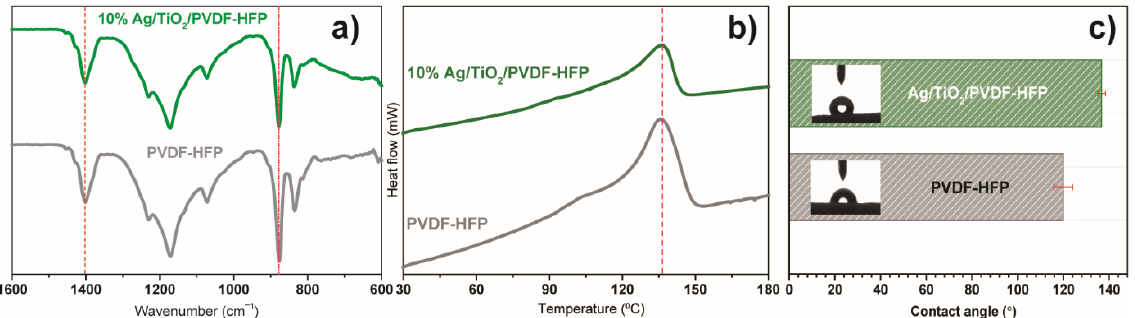
Figure 5. ( a ) FTIR, ( b ) DSC, and ( c ) contact angle measurements of pristine and Ag@TiO 2 /PVDF-HFP membranes.